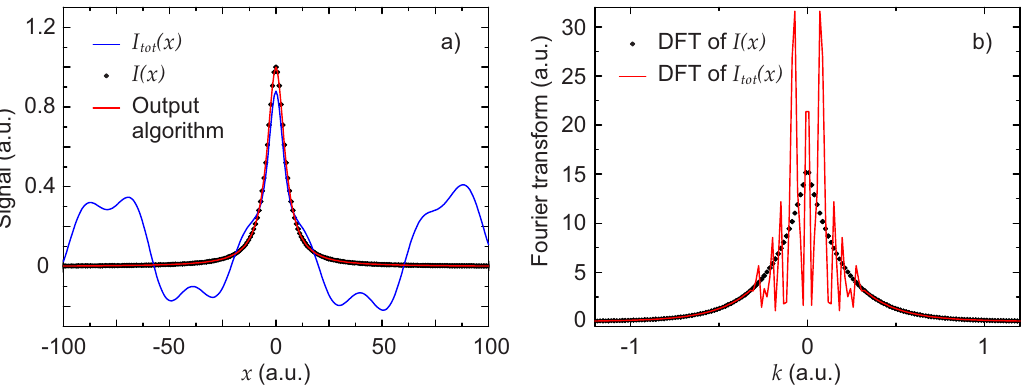
Figure 6. Third scenario: strong multiple disturbances. ( a ) simulated experimental total signal I tot ( x ) (blue line), Lorentzian line shape signal I ( x ) (black dots) and extracted signal obtained with the algorithm (red line); ( b ) DFT of the total signal | F ( I tot ( x ))( k ) | (red line) and DFT of the Lorentzian signal | F ( I ( x ))( k ) | (black